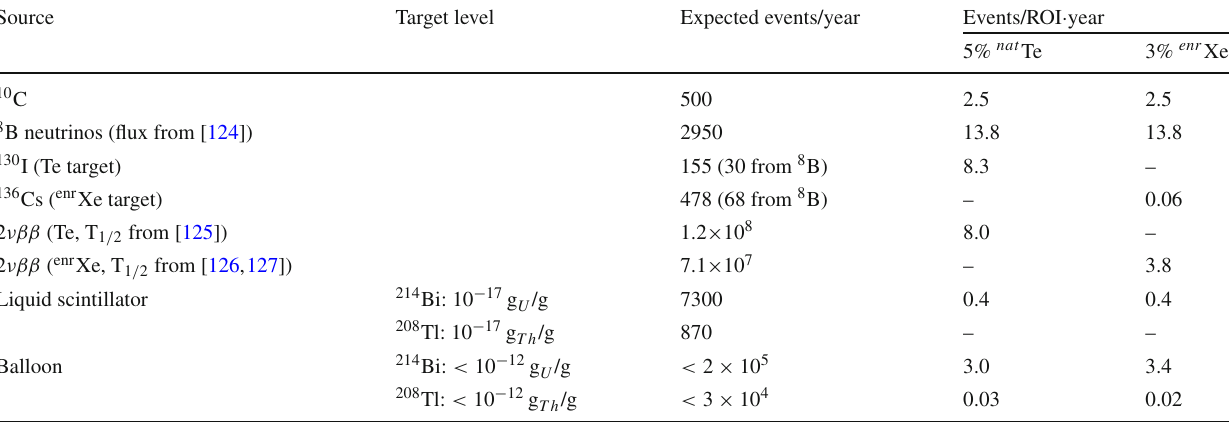
Table 7 Dominant background sources expected for the NLDBD search in Theia . The assumed loading is 3% for Xe, for a 136 Xe mass of 49.5t, and 5% for Te, for a 130 Te mass of 31.4t. The events in the ROI/year are given for a fiducial volume of 7m and an asymmetric